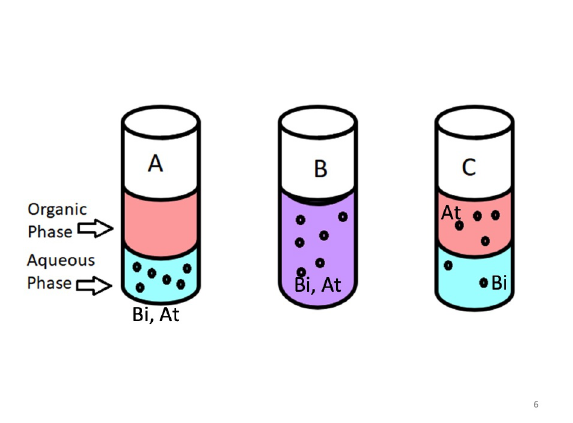
Figure 5. Schematic of liquid-liquid extraction process. The or- ganic phase is added to the aqueous phase, containing Bi and At (A). The vial is shaken (B). When the organic and aqueous layers again separate (C), At is in the organic phase, and Bi remains in the